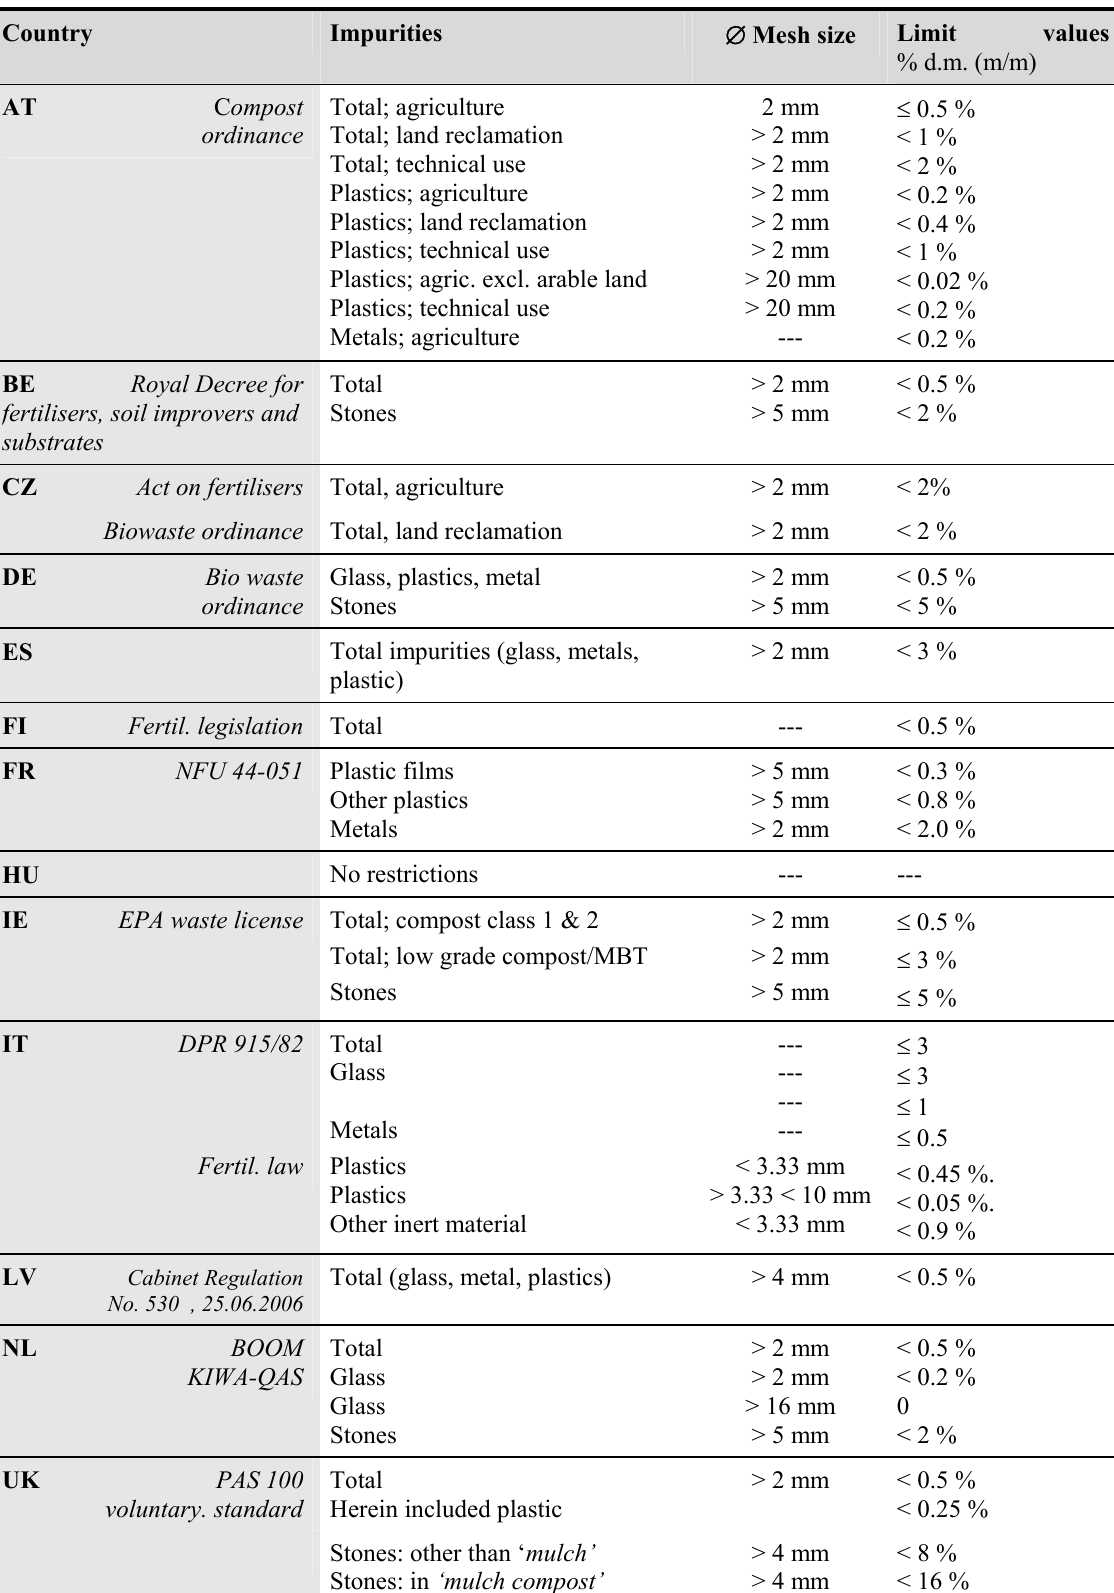
Table 21 Limitations for the content of impurities in compost in national compost regulations and